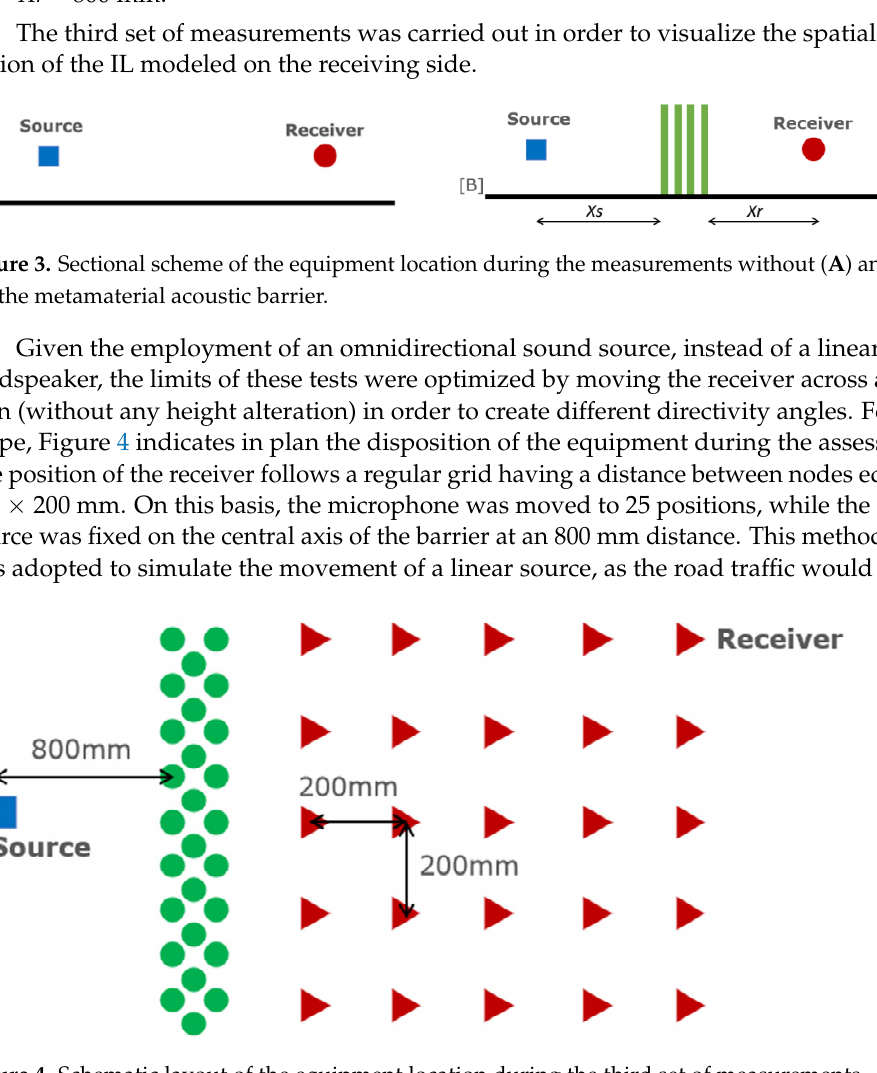
(B), the centered distance between wooden sticks is 18 mm (2B).